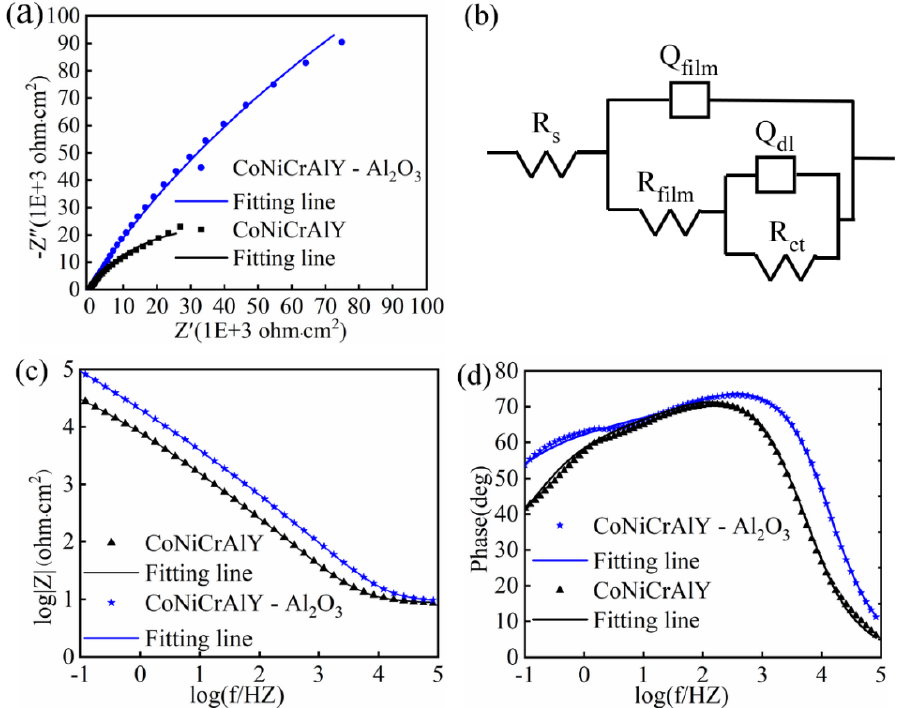
Figure 5. ( a ) Nyquist, ( b ) electrical equivalent circuit (EEC), and ( c , d ) Bode plots of the CoNiCrAlY- Al 2 O 3 coating and CoNiCrAlY coating in 3.5 wt.% NaCl solution under OCP condition. Table 7. Electrochemical parameters obtained from electrochemical impedance spectroscopy of